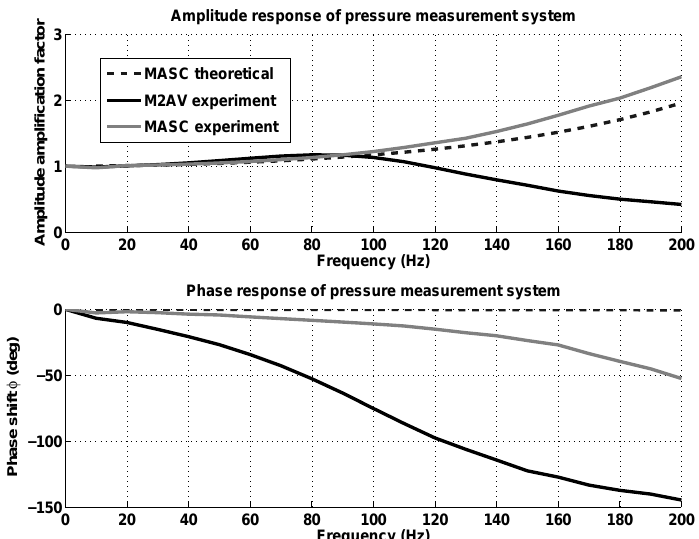
Fig. 13. Amplitude and phase response of the pressure measurement systems, including tubing, branches, transducer, etc. The MASC setup was investigated in an experiment (grey line) and theoretically with the Bergh and Tijdeman model (dashed line). The M 2 AV setup cannot be calculated with the model and thus is only investigated in an experiment (black line).